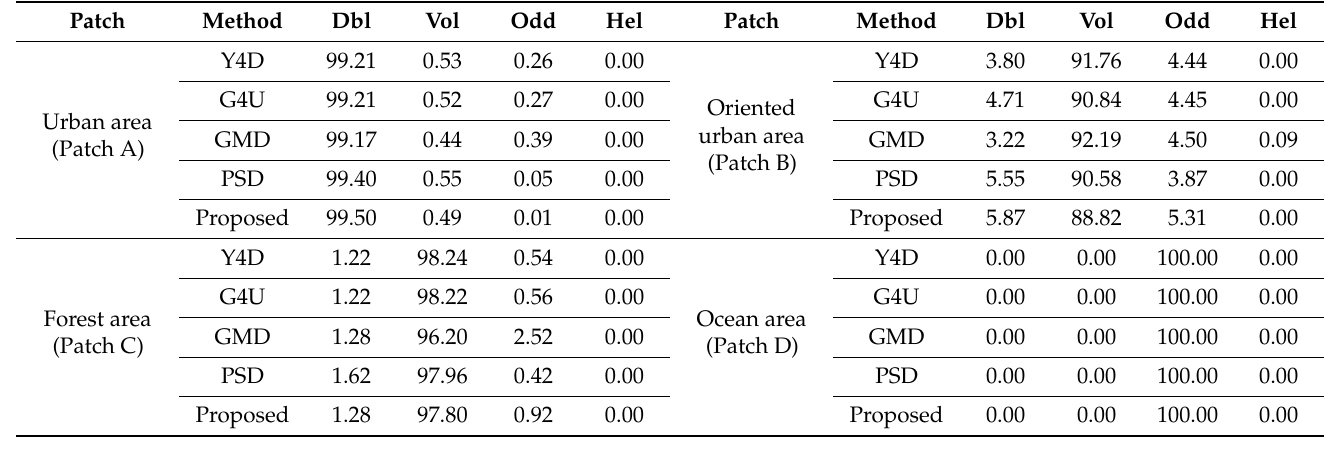
Table 3. The percentage of dominant scattering mechanism from the decomposition results of ALOS-2 data (%). Patch